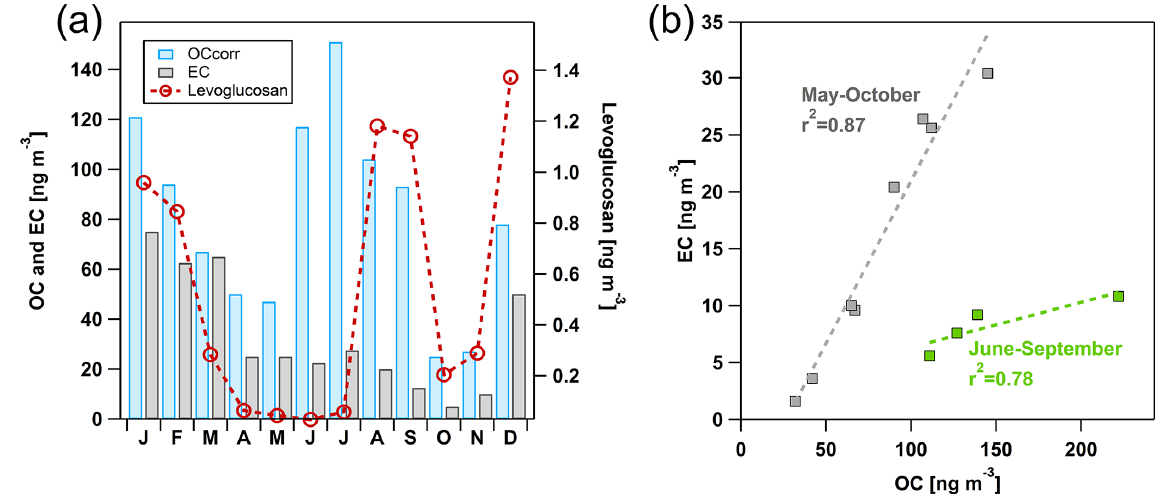
Figure 7. (a) Monthly means of EC, OC corrected for the positive sampling artefact, and levoglucosan in the PM 10 size fraction at the Zeppelin Observatory in 2019; (b) scatterplot of monthly means of EC and OC in PM 10 at the Zeppelin Observatory, October to May and June to September